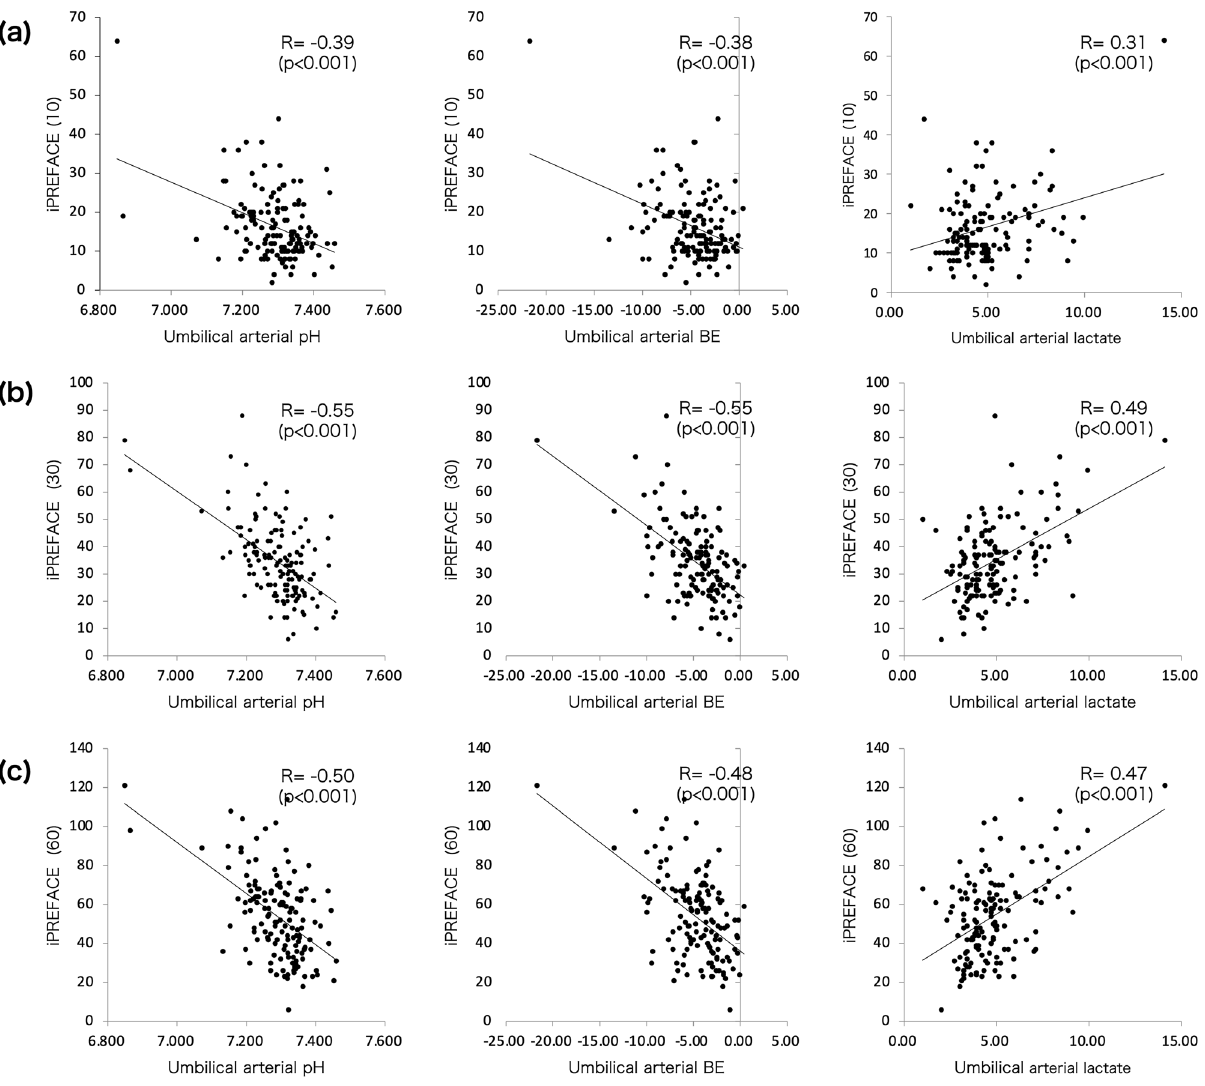
Figure 4. Linear regression analyses between iPREFACE scores and umbilical artery blood pH, BE, and lactate levels. ( a ) iPREFACE(10), (b) iPREFACE(30), ( c ) iPREFACE(60). BE, base